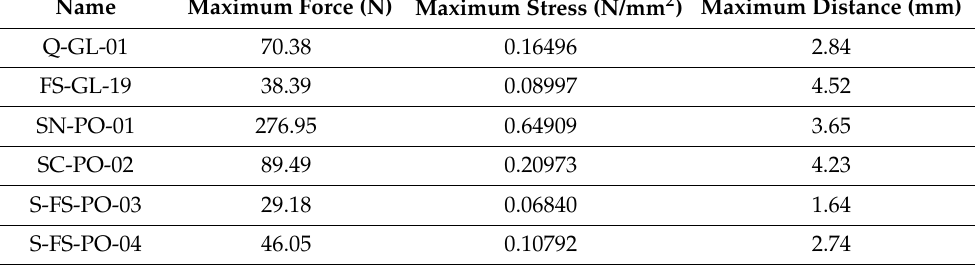
Table 5. Three-point flexural test of various samples. Name